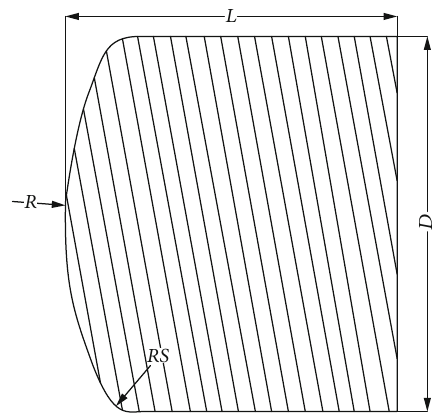
Figure 3: Schematic section of the blunt test model.